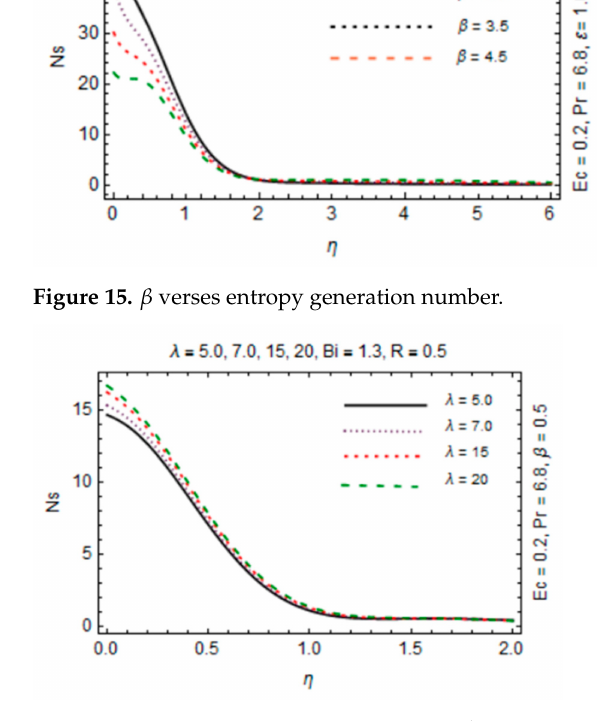
Figure 16. λ verses entropy generation number.